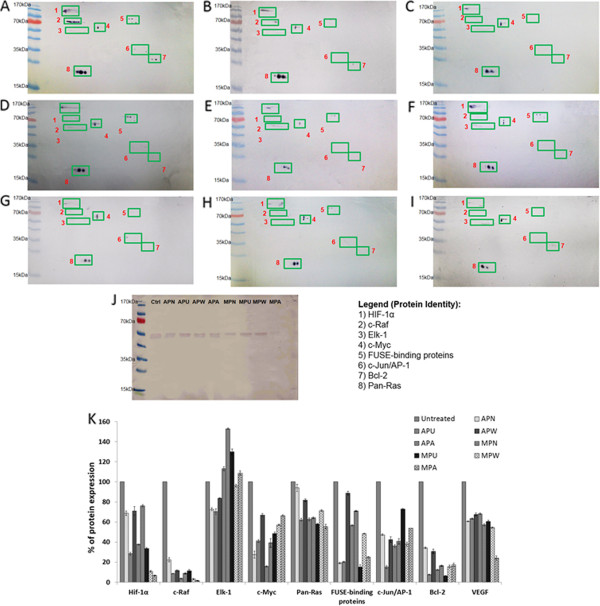
Expression level of Pan-Ras, c-Raf, c-Jun/AP-1, Elk-1, c-Myc, HIF-1α, Bcl-2, and FUSE-binding proteins in (a) untreated A549 cells and cells treated with (b) aqueous 
P. niruri, 
(c) aqueous 
P. urinaria, 
(d) aqueous 
P. watsonii, 
(e) aqueous 
P. amarus, 
(f) methanolic 
P. niruri, 
(g) methanolic 
P. urinaria, 
(h) methanolic 
P. watsonii, 
and (i) methanolic 
P. amarus
, (j) Expression level of VEGF in untreated-control and 
Phyllanthus
-treated A549 cells, (k) Percentage of individual protein expression analysed using Image J software.